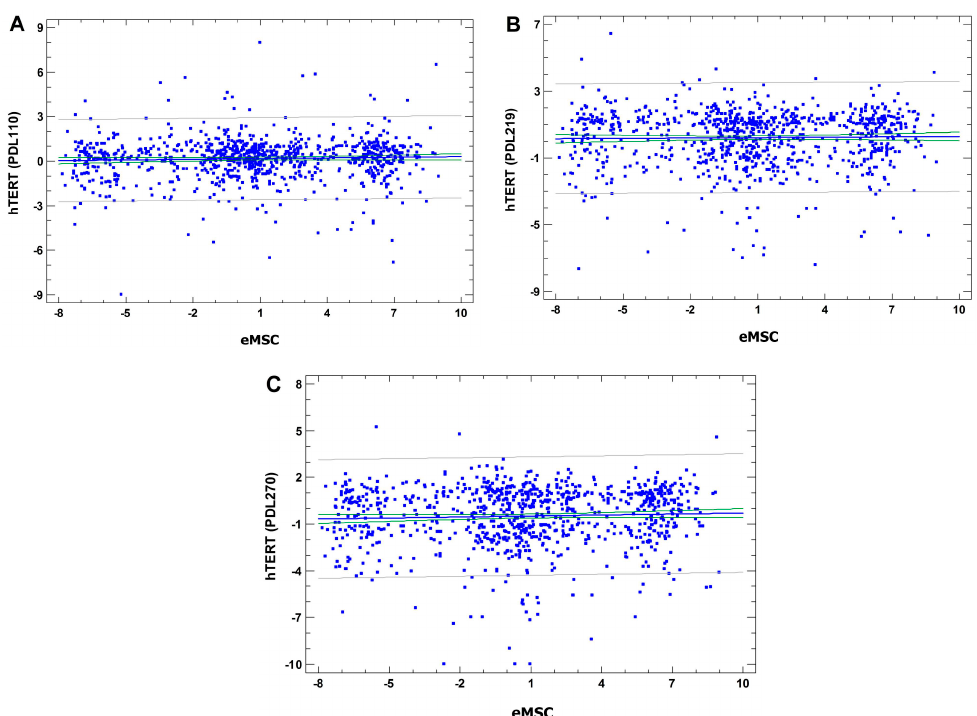
Figure 9. The absence of correlation between gene expression changes at various stages of hTERT-induced transformation in human bone marrow MSC (the data from Takeuchi, et al., 2015) and gene expression changes in SHS-SP. ( A ) the first stage (hTERT PDL110, r = 0.04, p = 0.2); ( B ) the second stage (hTERT PDL219, r = 0.02, p = 0.6); ( C ) the third stage (hTERT PDL270, r = 0.05, p = 0.2).